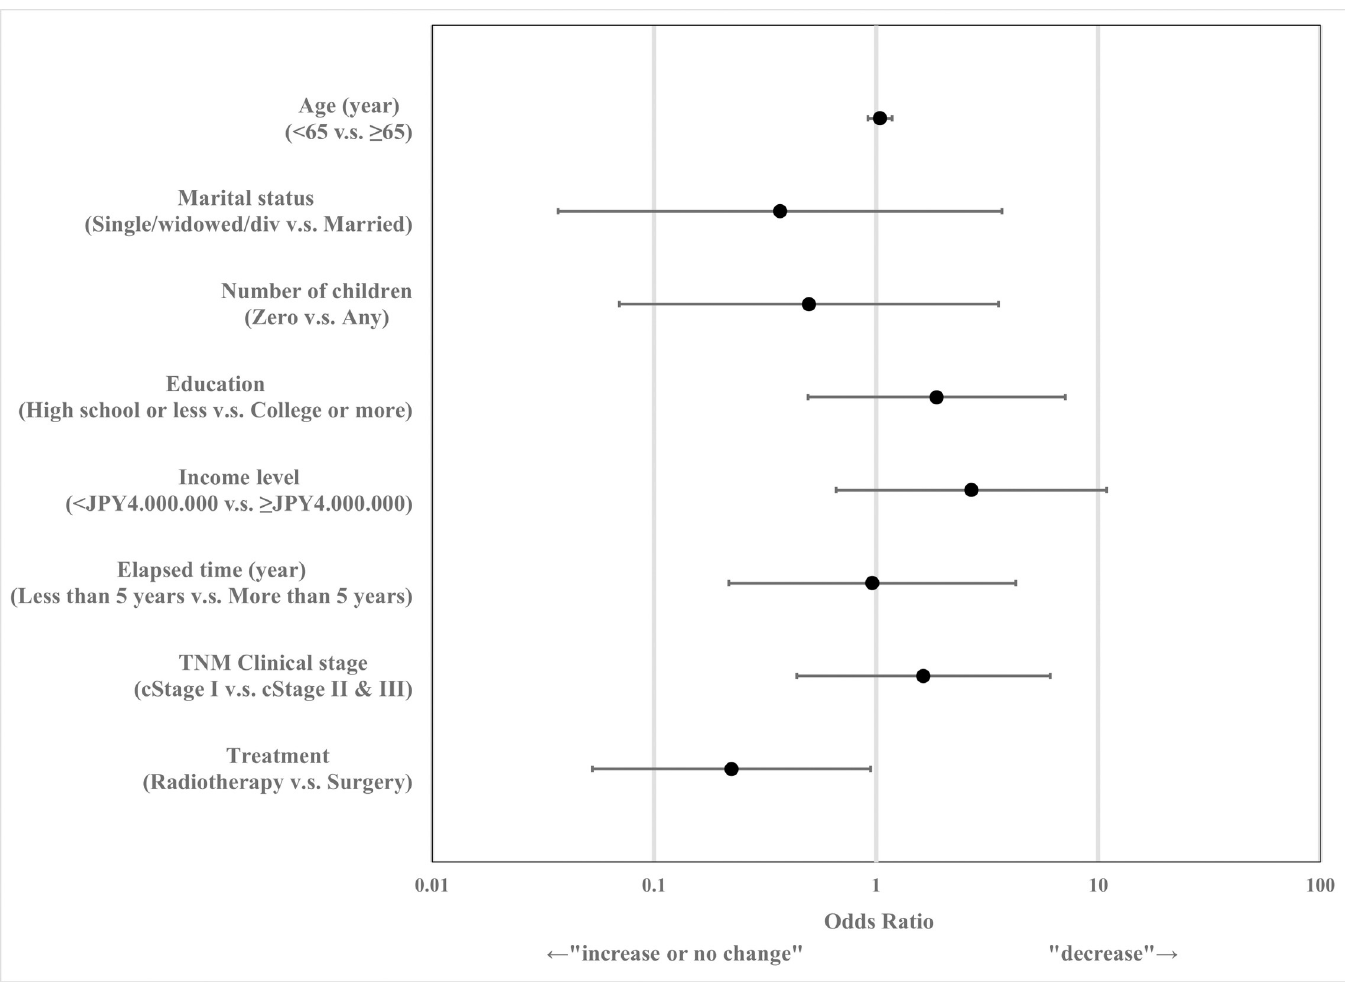
Fig 2. Odds ratio and 95% confidence intervals of annual income change after radical therapy for prostate cancer (JPY4,000,000 � $40,000).